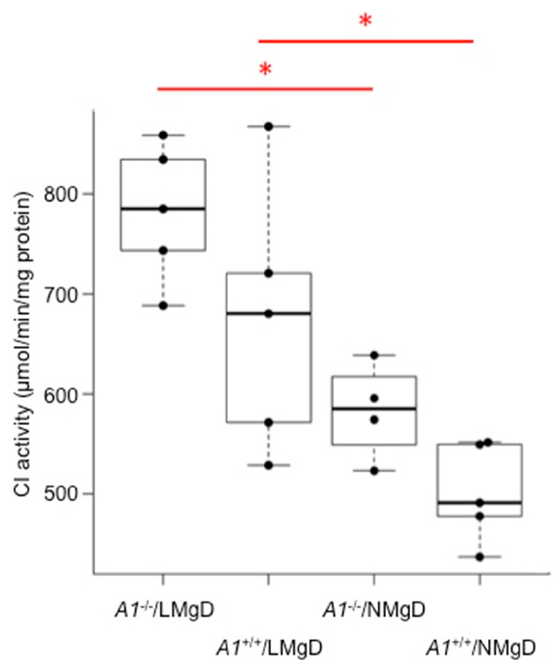
Figure A5. Post-hoc Tukey’s range test / KGDH. The KGDH activities presented as box-and-whisker plot overlaid with dot plot; dots represent raw input values for each analyzed group ( Slc41a1 − / − animals on LMgD, Slc41a1 +/+ animals on LMgD, Slc41a1 − / − animals on NMgD, and Slc41a1 +/+ animals on NMgD); * p < 0.05. Abbreviations: A1 , Slc41a1 ; KGDH, α -ketoglutarate dehydrogenase, LMgD, low Mg diet; NMgD, normal Mg diet.